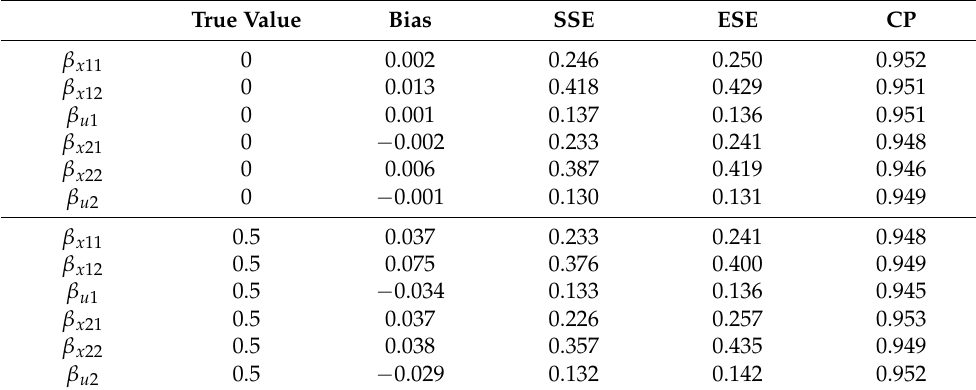
Table 4. Simulation results on estimation of β with mixed Poisson observation processes and r 1 = r 2 =